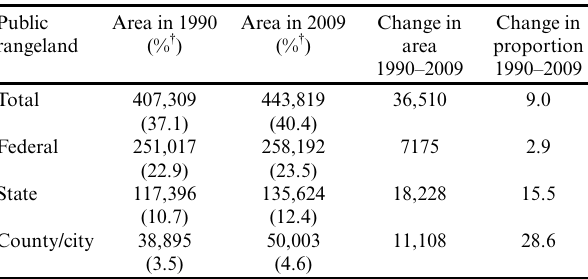
Table 2. Area (ha) of public rangeland in San Diego County, California, USA, and change in public rangeland between 1990 and